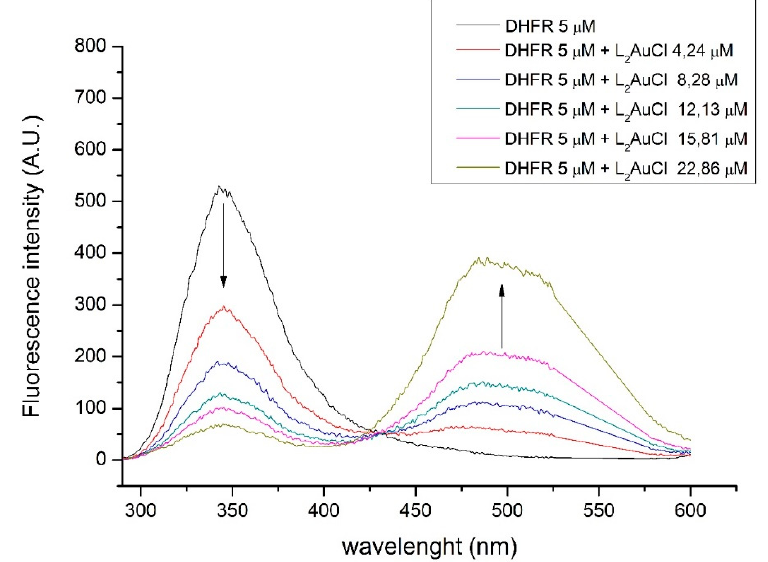
Figure 7. Quenching of DHFR’s tryptophan emissions according to the stepwise addition of (PPh 3 ) 2 AuCl ( exc = 280 nm). In the inset legend, the color corresponds to the curve and the respective concentrations.